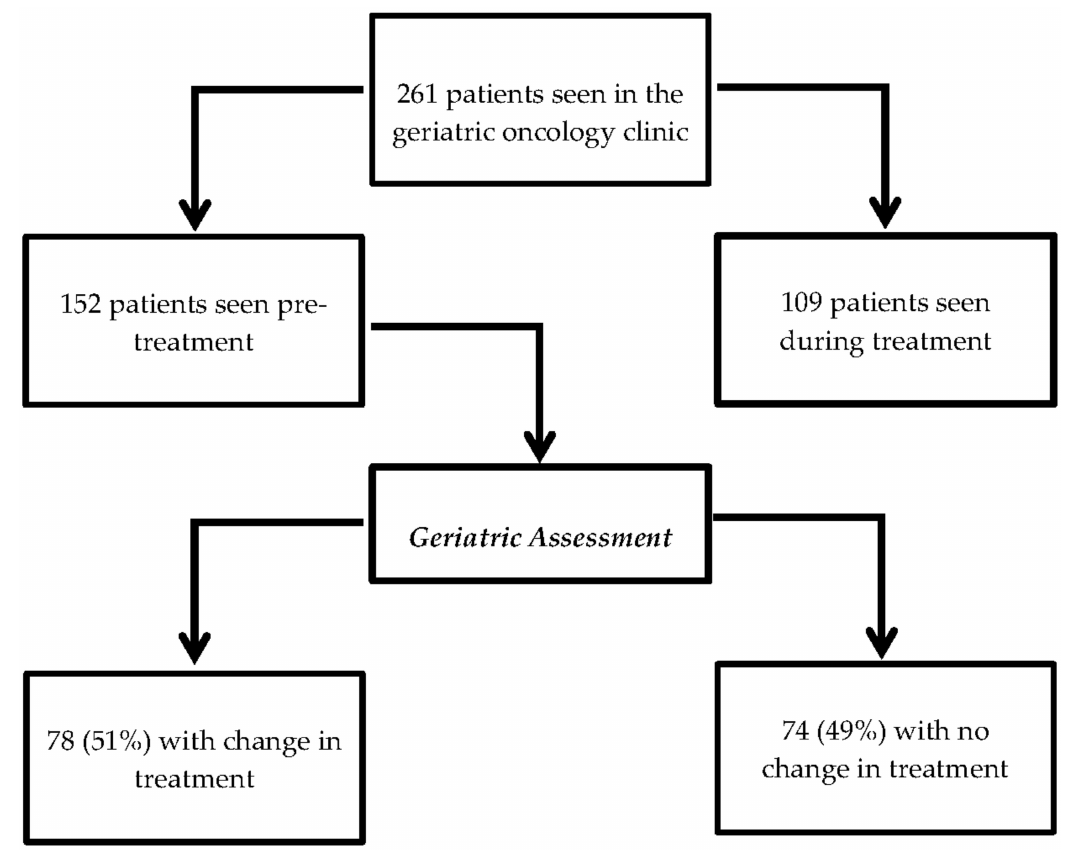
Figure 1. Study flow chart.